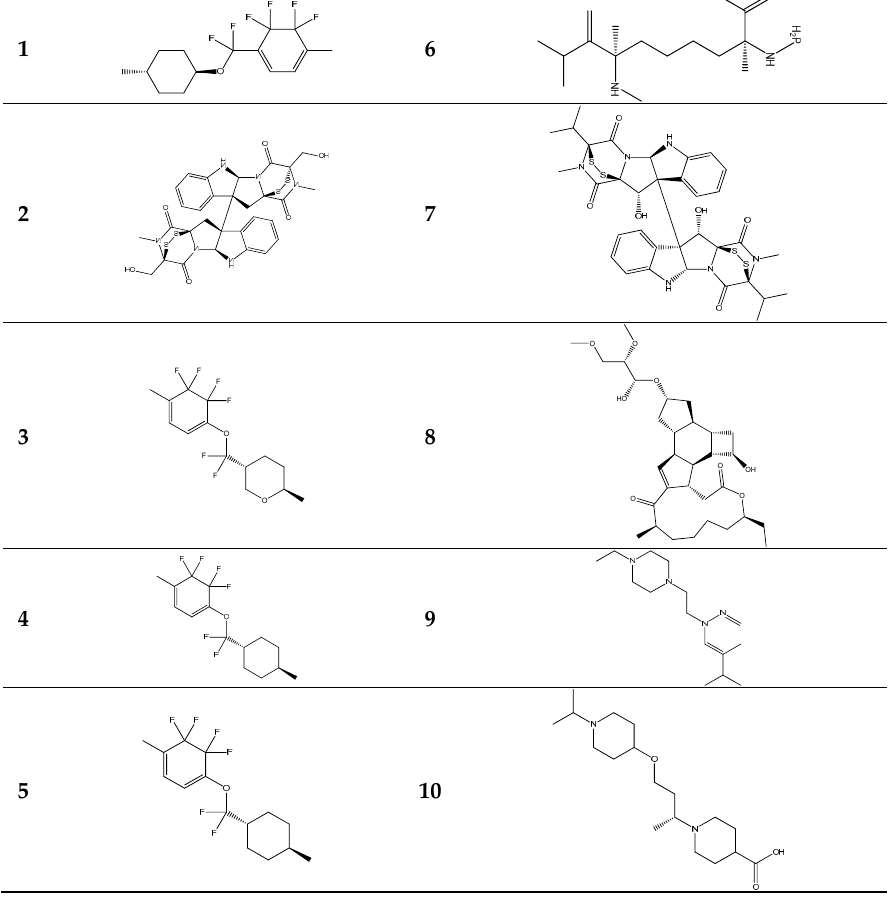
Figure 5. Virtual screening results for pharmacophore hypothesis A1P2R3R4R5R6R7.(numbered from 1 to 10).